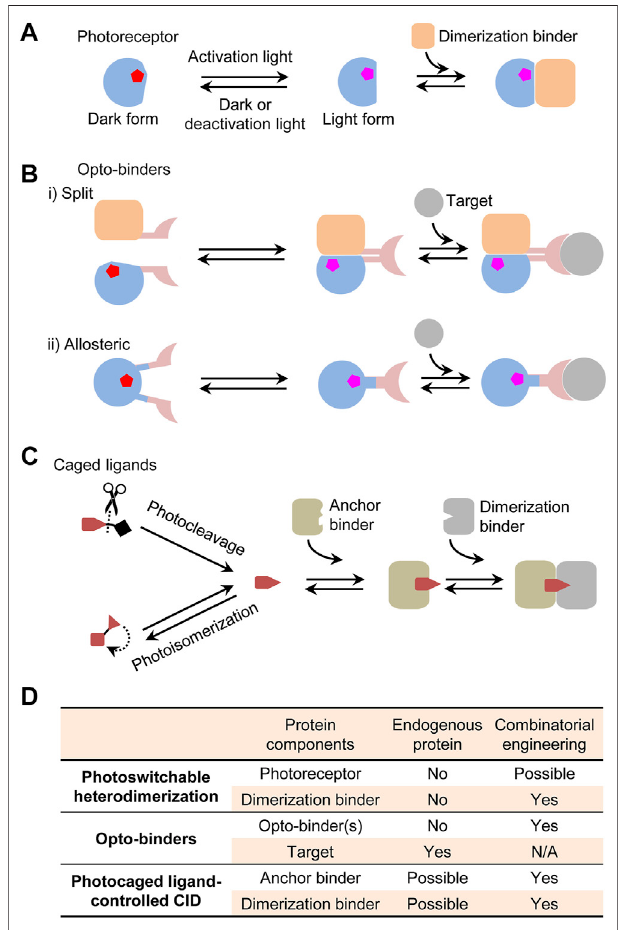
FIGURE 1 | Photoswitchable protein dimerization mechanisms. (A) Photoswitchable heterodimerization. Pentagons indicate chromophores in differentconformations(redormagenta).Althoughadimerizationbindermight speci fi cally recognize the light or dark form, only the binding to the light form is shown. (B) Opto-binders. Split and allosteric opto-binders function via the protein-fragment complementation and allosteric mechanisms, respectively. (C) Photocaged ligand-controlled CID. The uncaged ligand fi rst binds to ananchor binder and then the anchor binder-ligand complex, not the free anchor binder, is recognized by a dimerization binder. (D) Comparison of protein components in the dimerization systems regarding whether they can be an endogenous protein and whether they can be engineered by a combinatorial approach. N/A, not